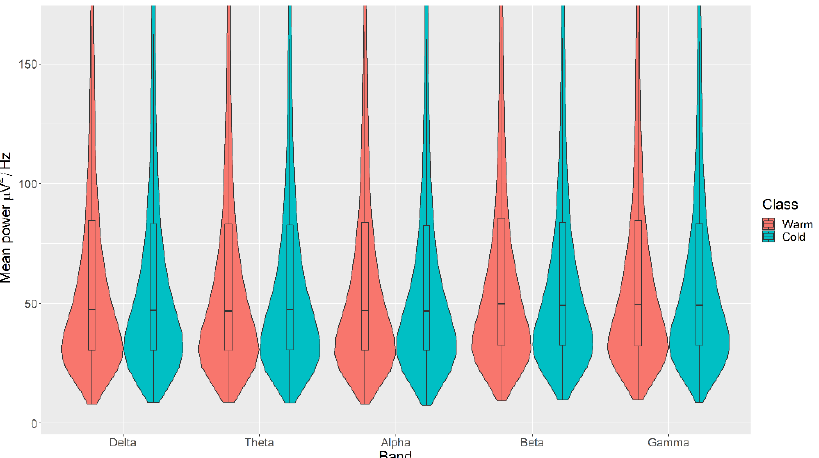
Figure 5. Violin plot of the average power in each of the bands for Warm and Cold categories for the Colour VDEP, ranging from low ( δ delta) to high ( γ gamma) frequencies.